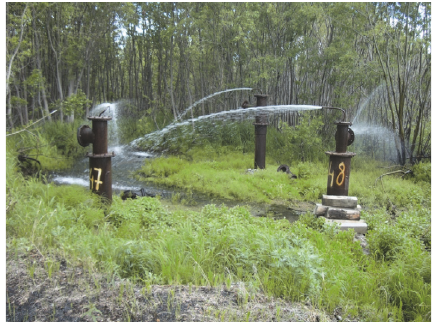
Figure 27: Bystrinsky groundwater reservoir wells, July 2013. Photo by A. V. Kiryukhin.